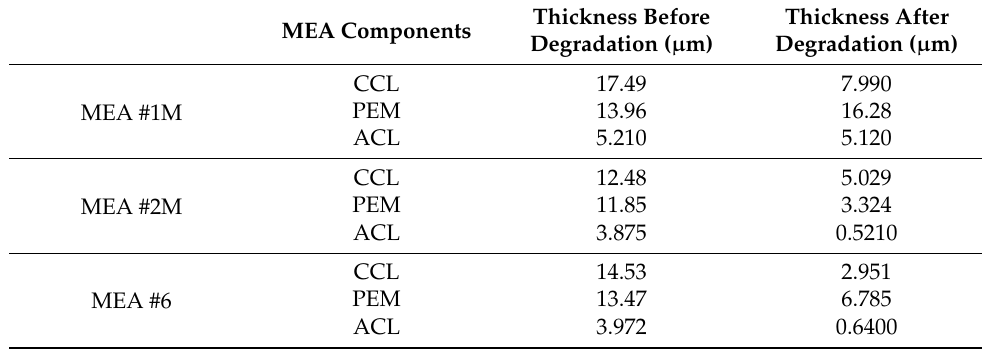
Table 5. The thicknesses of MEAs before and after the carbon degradation test.